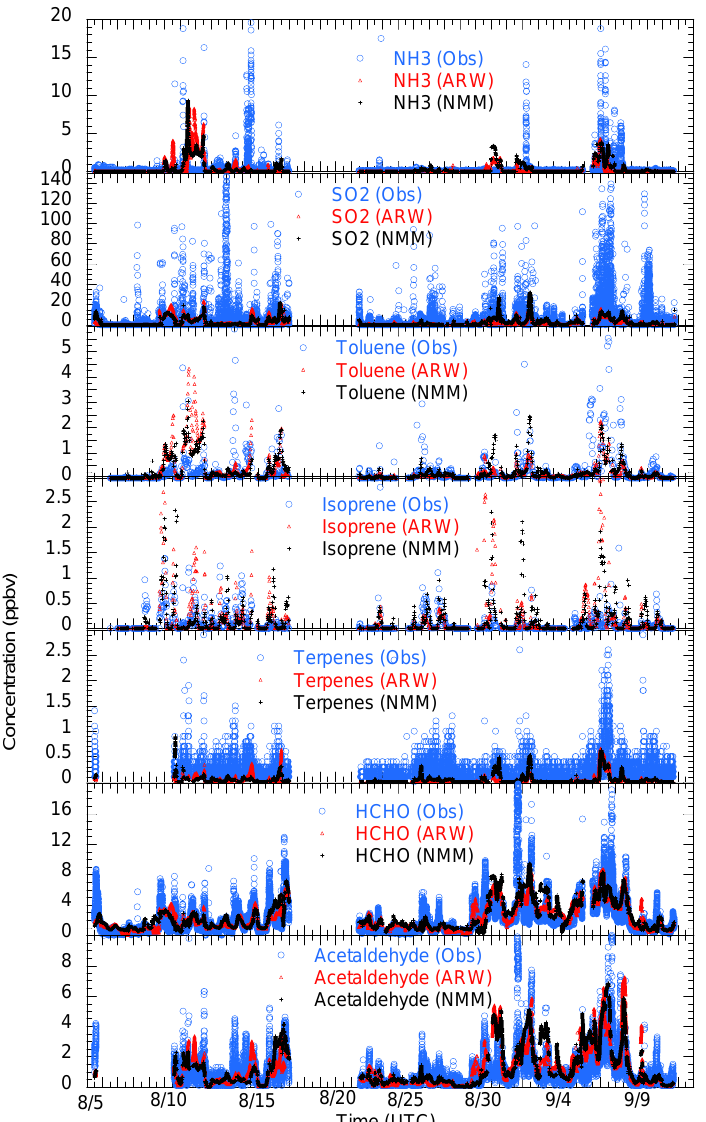
Fig. 6. Time series of observations and model predictions (NMM-CMAQ and ARW-CMAQ) for difference species on the basis of ship measurements over the Gulf of Mexico during the 2006 TexAQS/GoMACCS period.